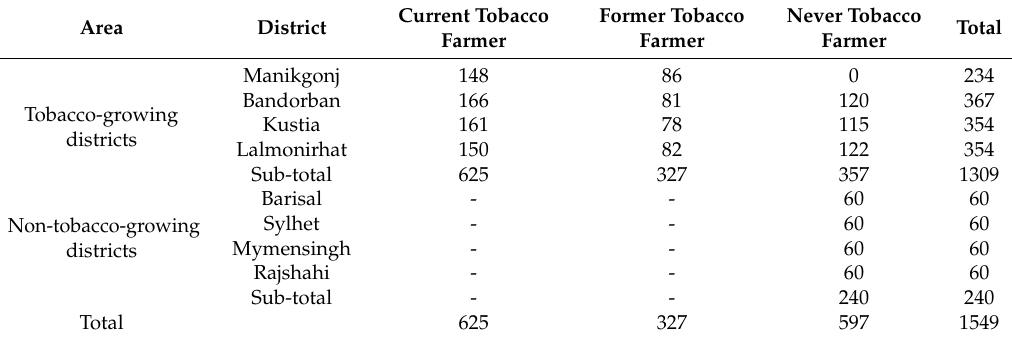
Sample size of current, former and never tobacco farmers in tobacco-growing and non-tobacco-growing sample